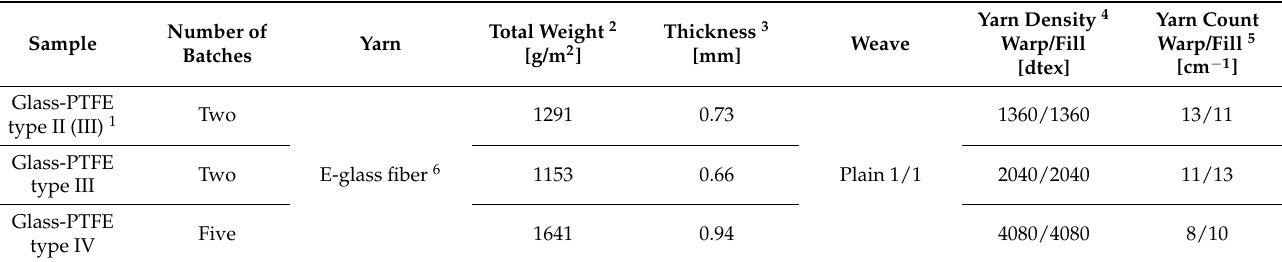
Table 3. Specifications of the investigated material.